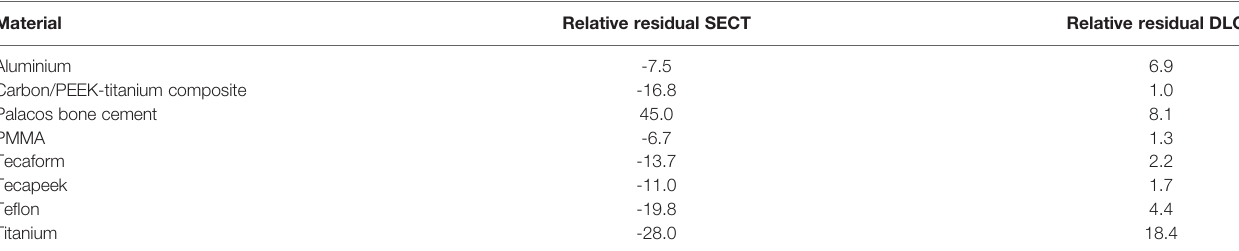
TABLE 3 | Accuracy of SECT- and DLCT-based SPR predictions across different non-tissue materials. Material